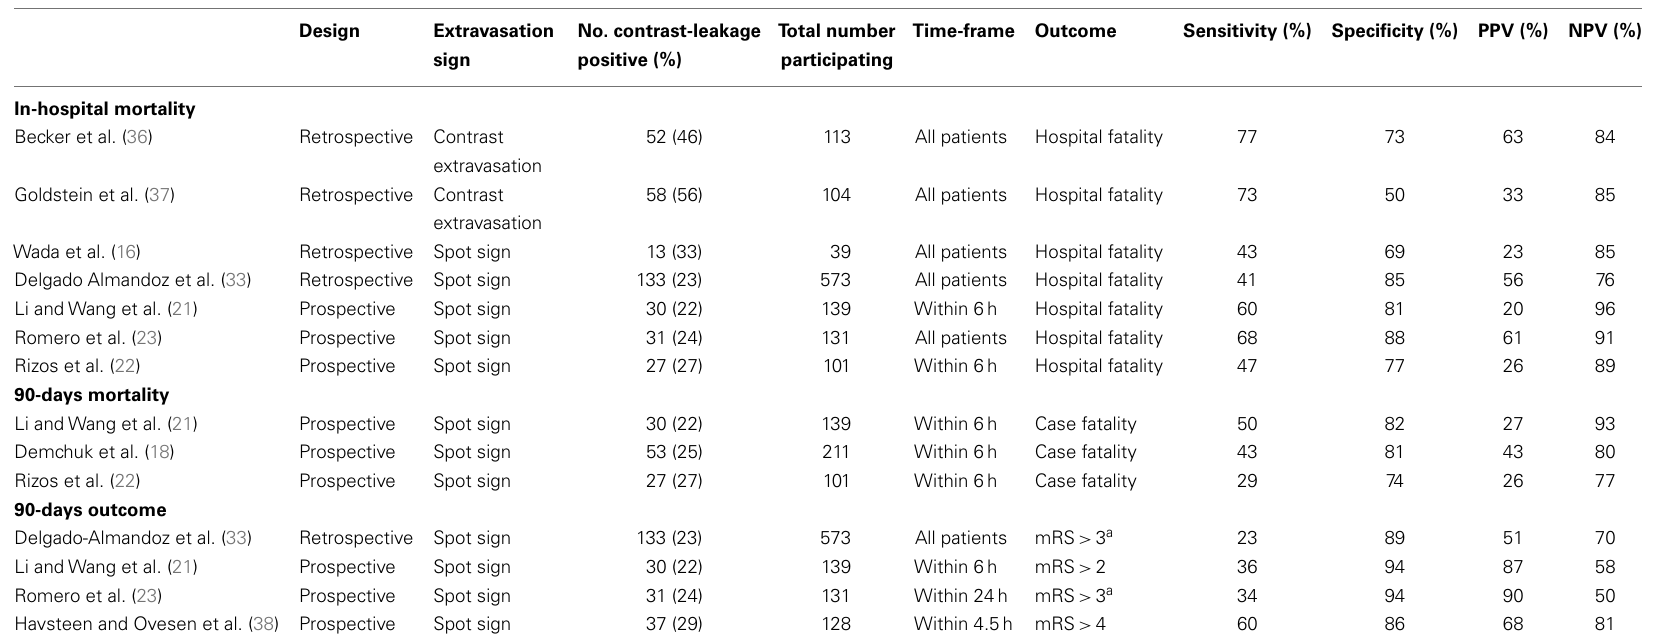
Table 2 | Effect of contrast-leakage in predicting outcome